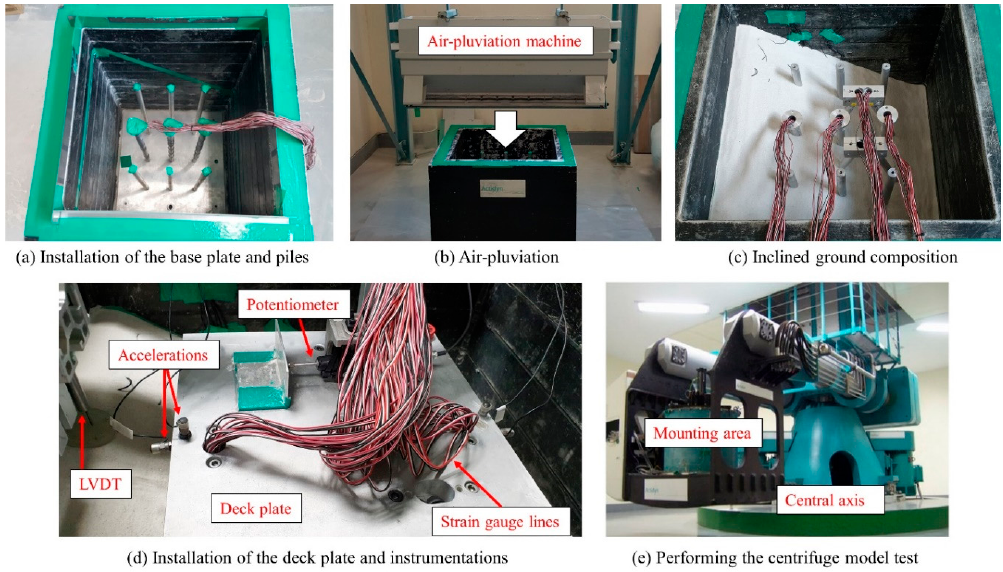
Figure 2. Procedure of centrifuge model test (IAI55 model).